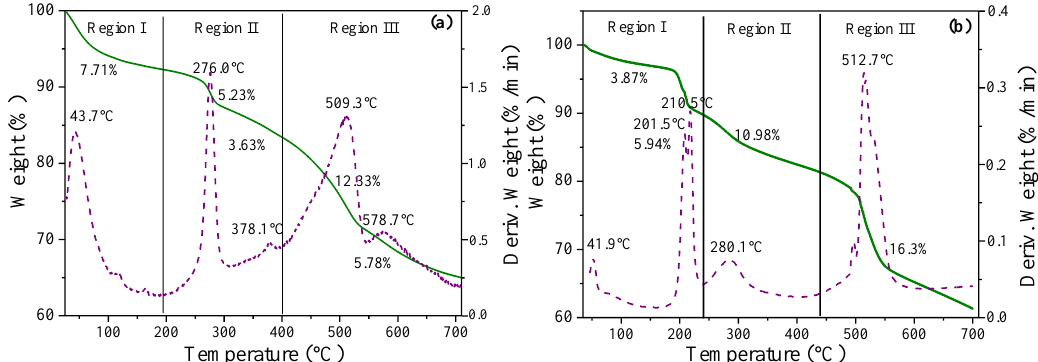
Figure 4. Thermogravimetric analysis (TG / DTA) of the hybrid compounds for ( a ) ZHN–CA and ( b ) ZHA–CA.